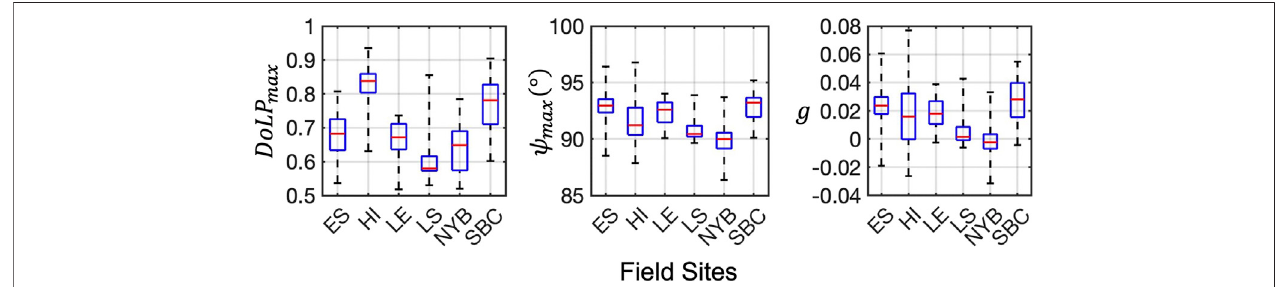
FIGURE 6 | From left to right panel: Box-whisker plots of the peak magnitude DoLP max , peak angle ψ max and asymmetry parameter g of the measured DoLPs at the six fi eld sites. Blue box top and bottom bars are the 75 th and 25 th percentile. Red bar is the median. Top and bottom whiskers indicate maximum and minimum.